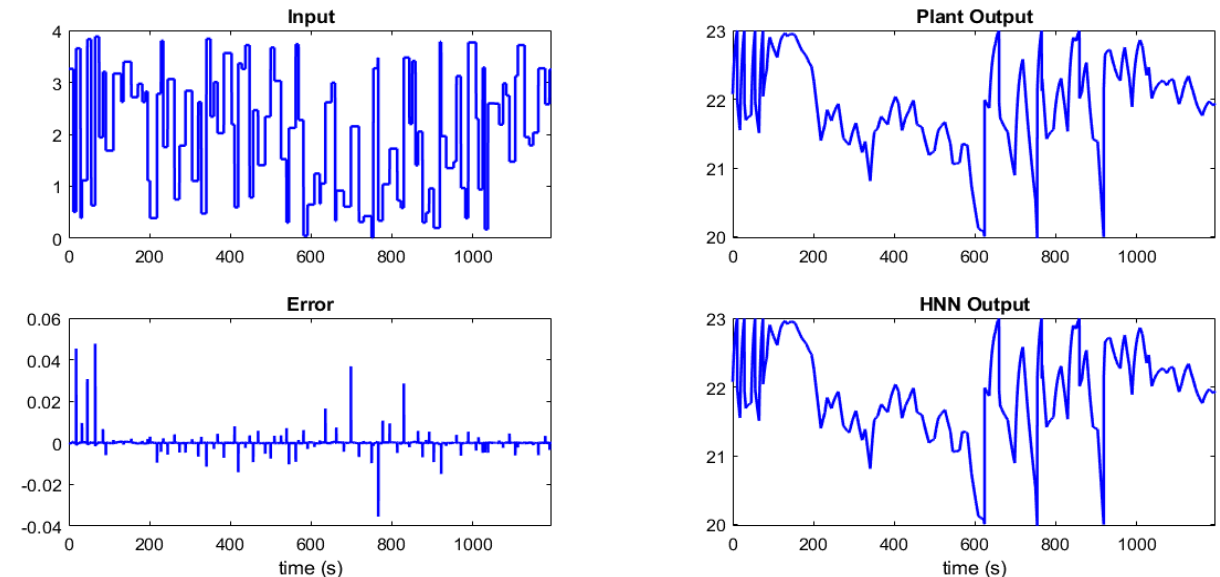
Figure 7. Predictive control of variable resources using neural networks in compliance with Weibull PDF